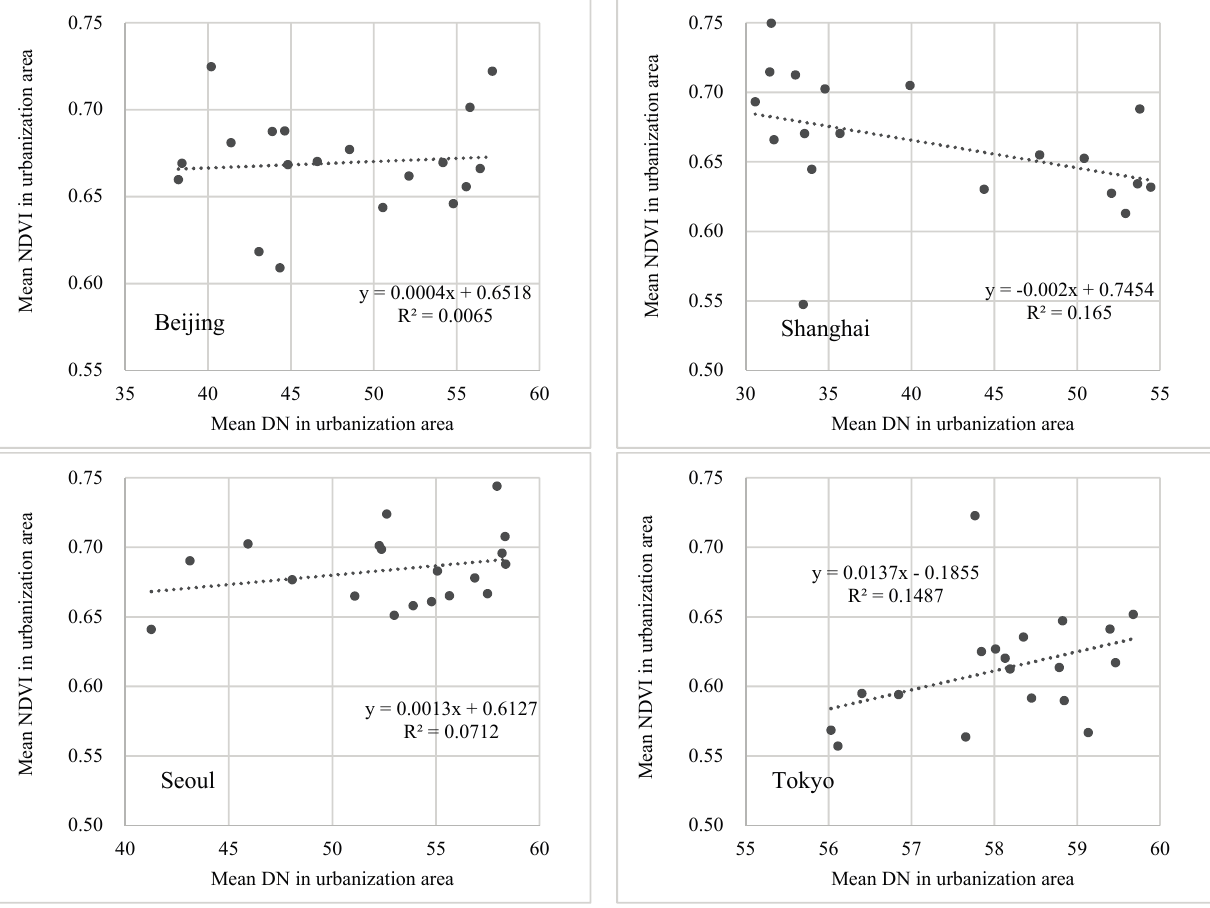
Figure 7. The relation between mean NDVI and mean light in the urbanization areas during 1992–2010 in some Northeast Asia cities. Shanghai signifies the Yangtze River Delta urban